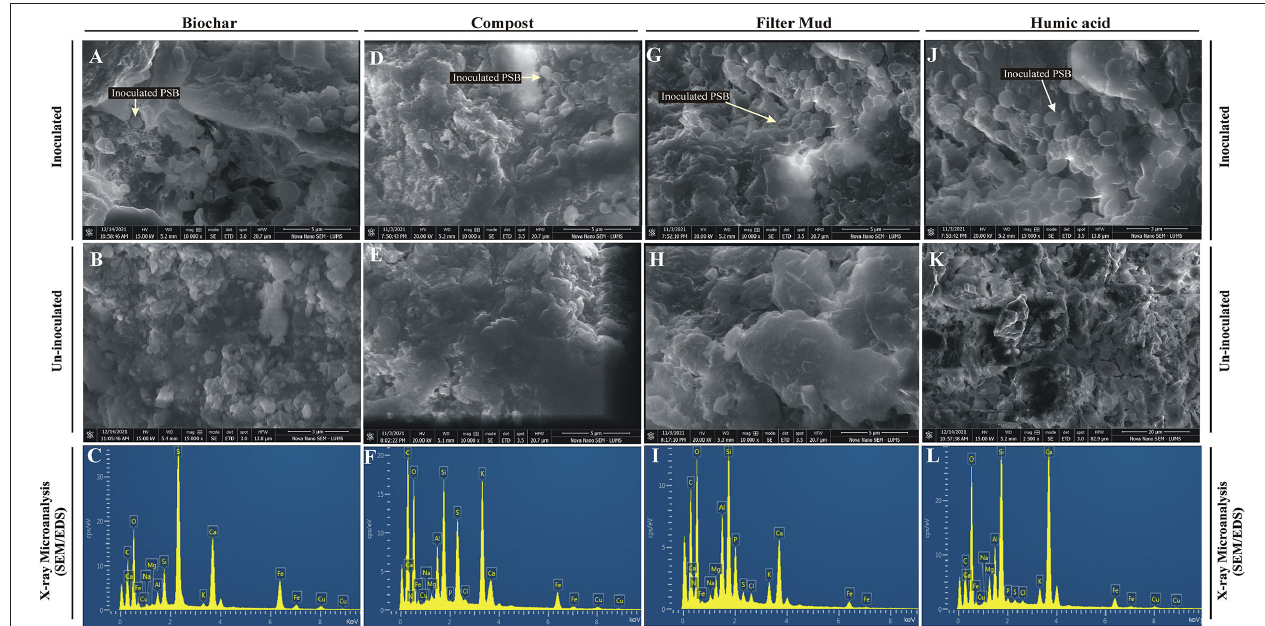
FIGURE 4 | Field emission scanning electron microscopic analysis and energy dispersive X-ray spectroscopy of bioformulations. FESEM analysis of inoculated Biochar (A) , compost (D) , filter mud (G) and Humic acid (J) to visualize PSB and composition/ structure of carrier materials compared to non-inoculated filter mud (B) , compost (E) , Biochar (H) and Humic acid (K) . The chemical elements microanalysis of the filter mud (C) , compost (F) , Biochar (I) and Humic acid (L) is analyzed through